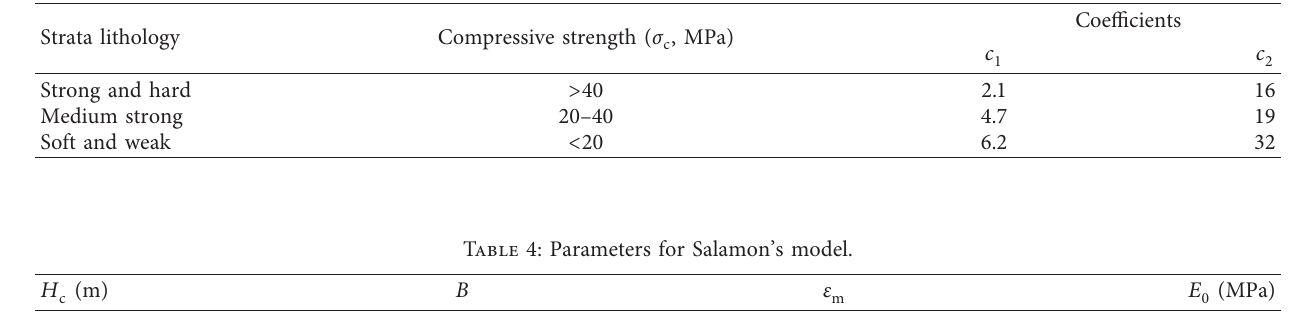
Table 3: Coefficients for average height of caving zone.